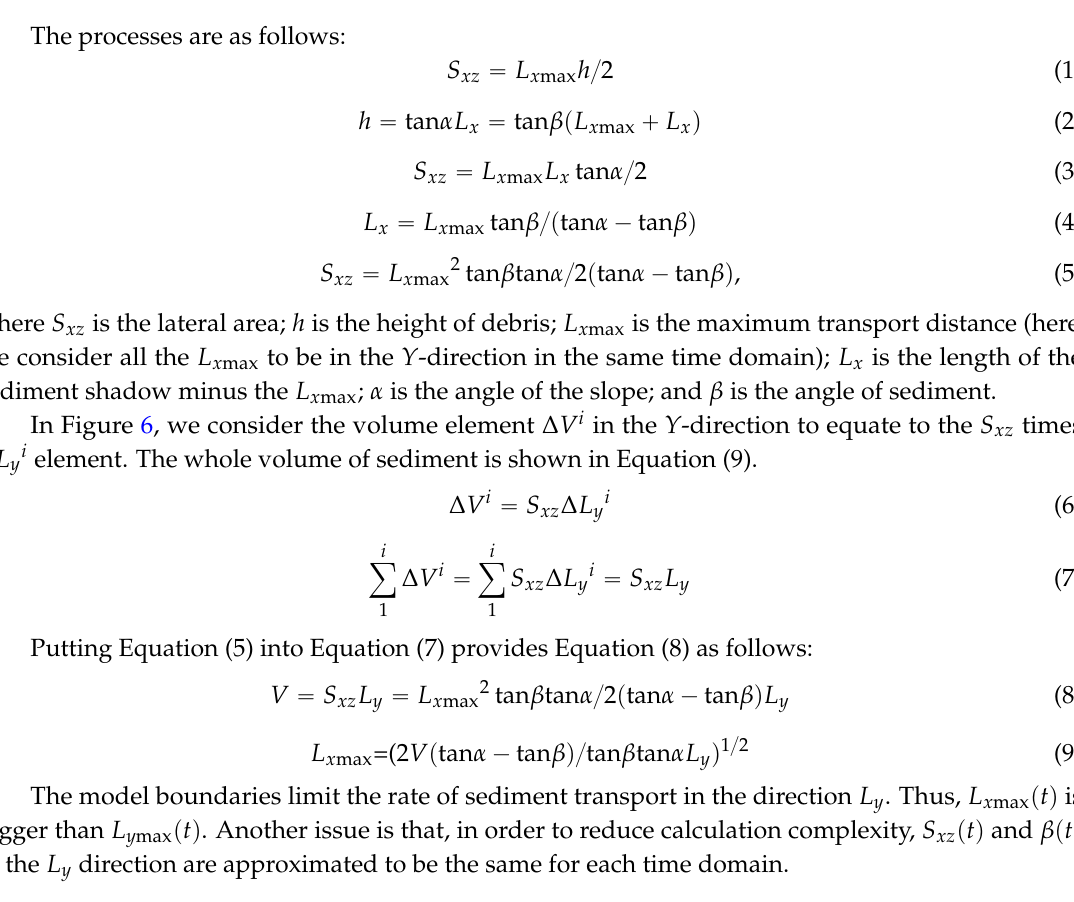
Figure7. Lateral view of eroded soil sediment (debris). Figure 7. Lateral view of eroded soil sediment